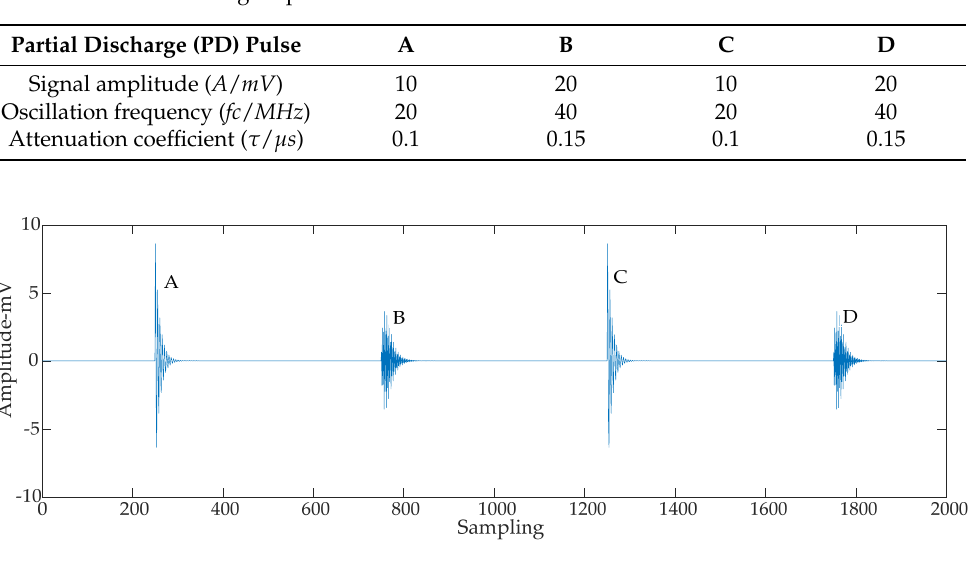
Figure 1. Partial discharge (PD) simulation signals.